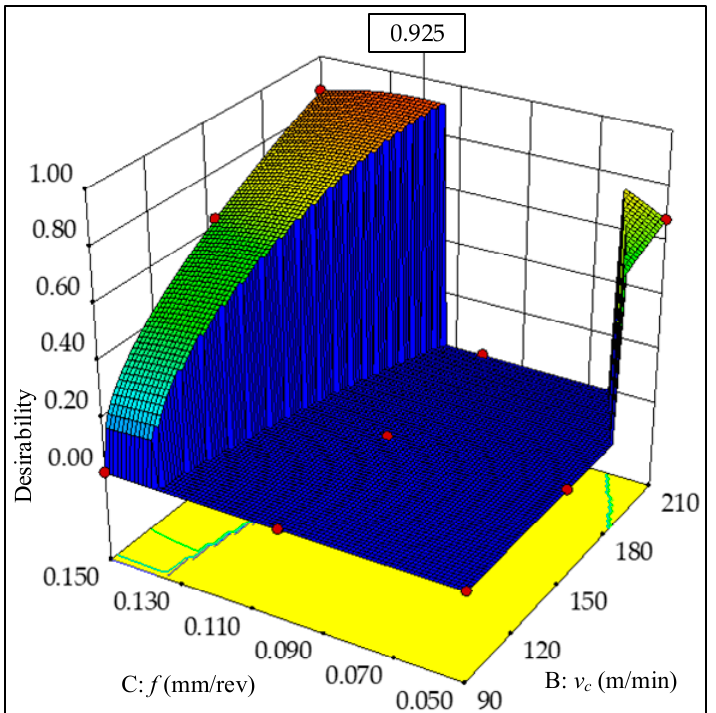
Figure 14. Ramp function graph of desirability (LEC Mode).